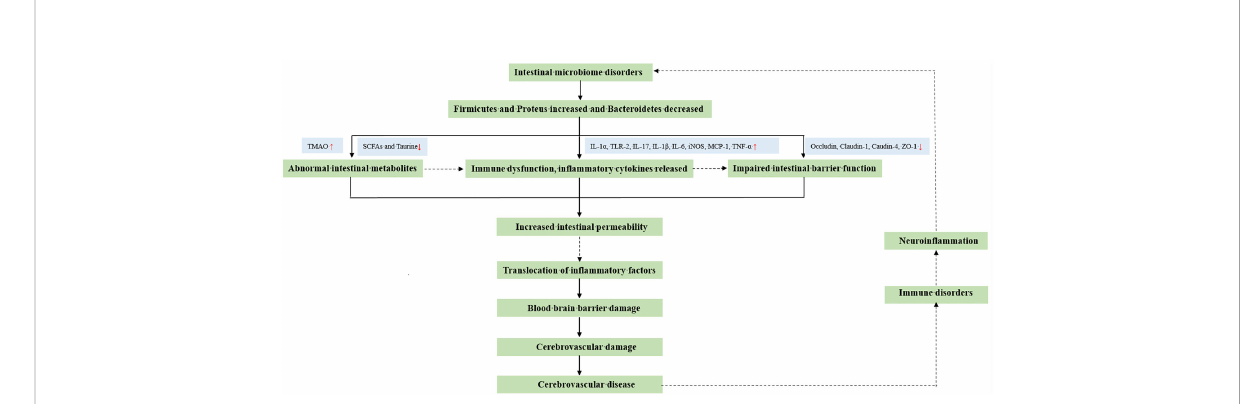
FIGURE 1 Potential impact mechanism between intestinal microorganisms and cerebrovascular